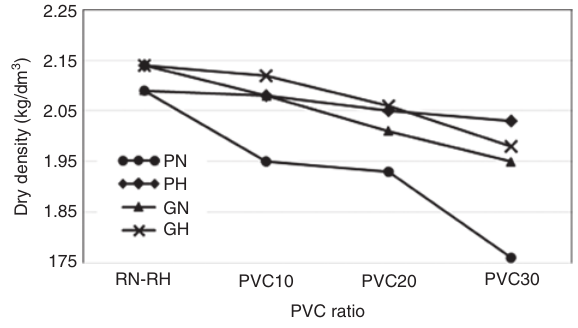
Figure 5 Slump of polyvinyl chloride-containing concretes.